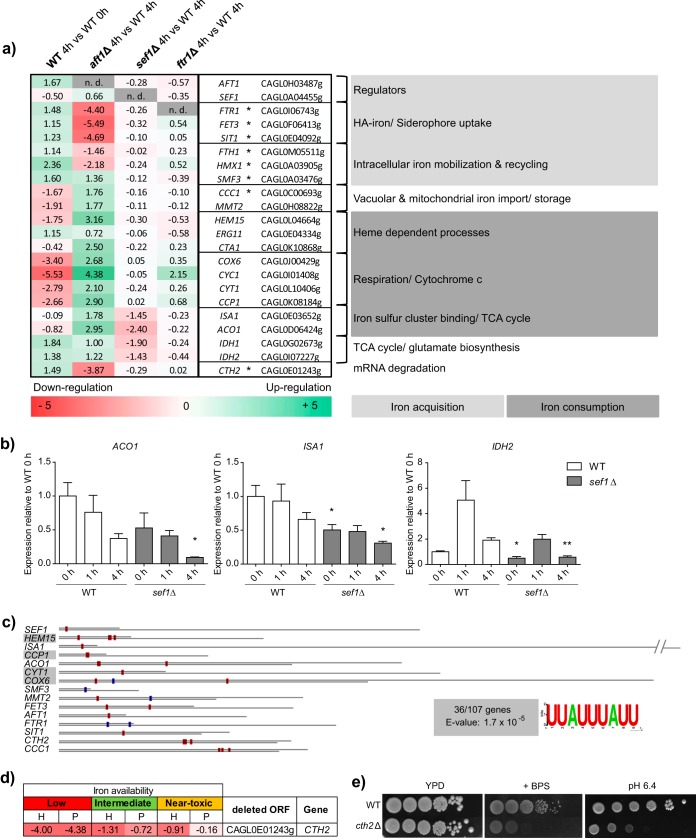
Comparative transcriptional profiling shows major dysregulation of iron metabolism-associated genes in the aft1Δ mutant and reveals that Cth2 is a potential posttranscriptional regulator. (a) Relative mRNA levels of iron-associated genes in the WT strain compared to the aft1Δ, sef1Δ, and ftr1Δ mutants under iron starvation conditions. Microarray data are displayed in a normalized log2 scale for downregulation (negative numbers, shaded red), upregulation (positive numbers, shaded green), or no detected expression (n.d.) of target genes. Asterisks (*) indicate target genes that carry one or multiple copies of the Aft1 consensus-binding site PyPuCACCCPu in the 5′ UTR. (b) qRT-PCR expression of the following genes affected by SEF1 deletion relative to the levels seen with the WT at 0 h: ACO1 (encoding mitochondrial aconitase), ISA1 (encoding an iron sulfur cluster assembly), and IDH2 (encoding isocitrate dehydrogenase). Data represent means of results of biological triplicate experiments ± SEM (nd, no expression detected). Data are from an unpaired Student’s t test and represent results of comparisons to WT results from the same time point (*, P value < 0.05; **, P value < 0.01). (c) The postulated target consensus motif of the Cth2 mRNA-degrading protein (5′-UUAUUUAUU-3′) is found in the downstream sequences of 36 (of 106) genes normally downregulated in the WT strain upon iron starvation (0 h to 4 h) (volcano plot; 2-fold downregulation; P value = 0.05; false-discovery-rate [FDR] corrected) but is artificially upregulated in the aft1Δ strain (4 h against WT) (volcano plot; 2-fold upregulation; P value = 0.05; FDR corrected). Motifs (red box, forward strand; blue box, reverse strand) are shown for the previously displayed striking microarray genes in the annotated 3′ intergenic region (lower gray line) or the predicted 3′ UTR of the target gene (upper gray line) in proportion to the actual length (1 dot represents 4 bp; // indicates a discontinued display). (d) Growth of the cth2Δ mutant under low-iron conditions (10 µM FeCl3), intermediate-iron conditions (500 µM FeCl3), and near-toxic iron conditions (40 mM FeCl3) in Chelex-treated SD (pH 5.8) compared to the WT strain (zero, shaded white) determined by assessing the time of half-maximal growth (H) and the plateau height (P). Positive numbers indicate improved growth (shaded green), and negative numbers indicate growth defects (shaded red). Data represent means of results from triplicate experiments. (e) Growth of the cth2Δ mutant in the presence of the iron chelator BPS (50 µM) and under alkaline conditions (pH 6.4) on solid media.